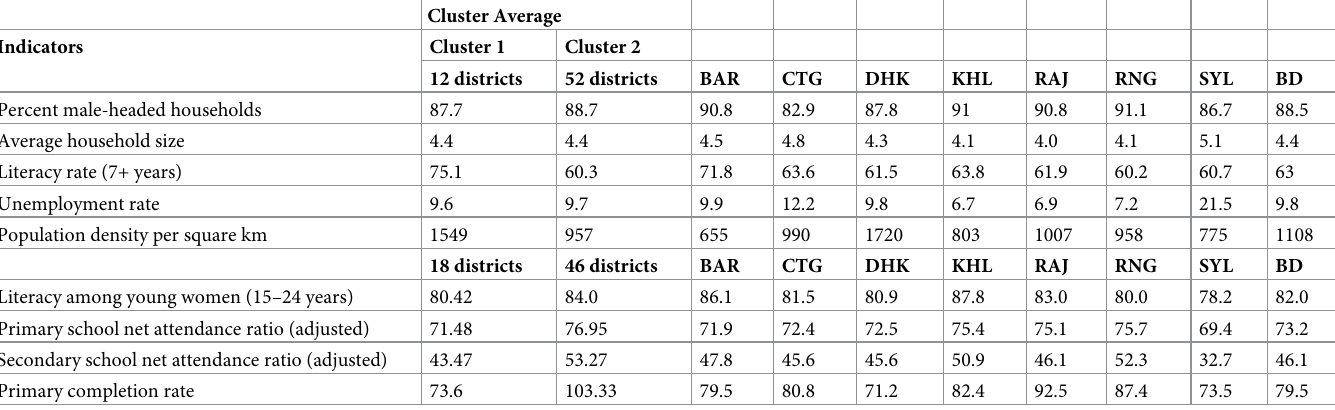
Table 1. Cluster averages of districts along with averages of the divisions and Bangladesh as a whole based on demographic indicators and literacy and educational